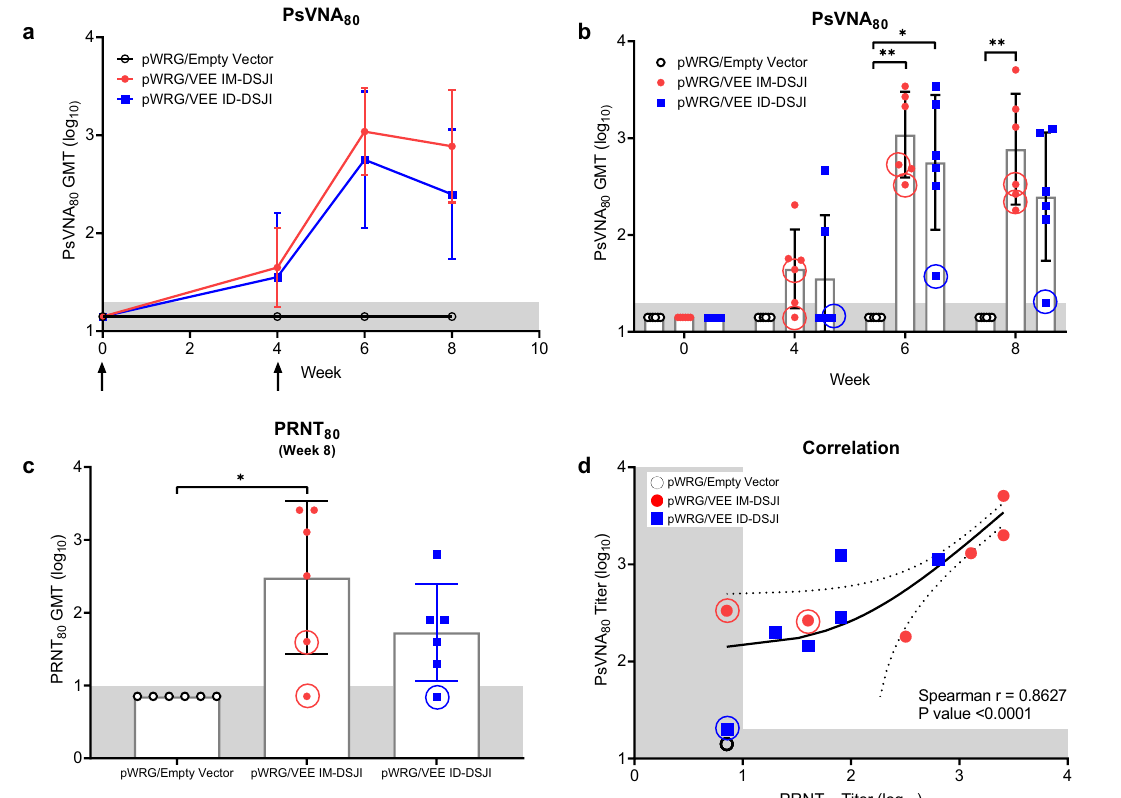
Fig. 2 pWRG/VEE delivered by IM- or ID-DSJI elicits anti-VEEV neutralizing antibodies. a Temporal anti-VEEV GP neutralizing antibody responses and ( b ) PsVNA neutralizing antibody titers in vaccinated nonhuman primates. c PRNT titers 4 weeks post 2nd vaccination. The shaded areas represent the assay limit based on the lowest dilution of serum tested. Arrows represent vaccination time points. Data represent the group geometric mean ± geometric SD. * p < 0.05, ** p < 0.01. d Correlation analysis to evaluate the relation of the VEEV PsVNA 80 and PRNT 80 . For panels ( a ) and ( c ), p values were determined by one-way ANOVA with Tukey ’ s multiple comparison test. For panel ( b ), p values were determined by two-way ANOVA with Tukey ’ s multiple comparison. For panel ( d ), linear regression and 95% CI is shown as line and dotted lines, respectively. Circled symbols represent individual animals in VEEV-vaccinated groups that developed a fever >3 °C above baseline after VEEV aerosol